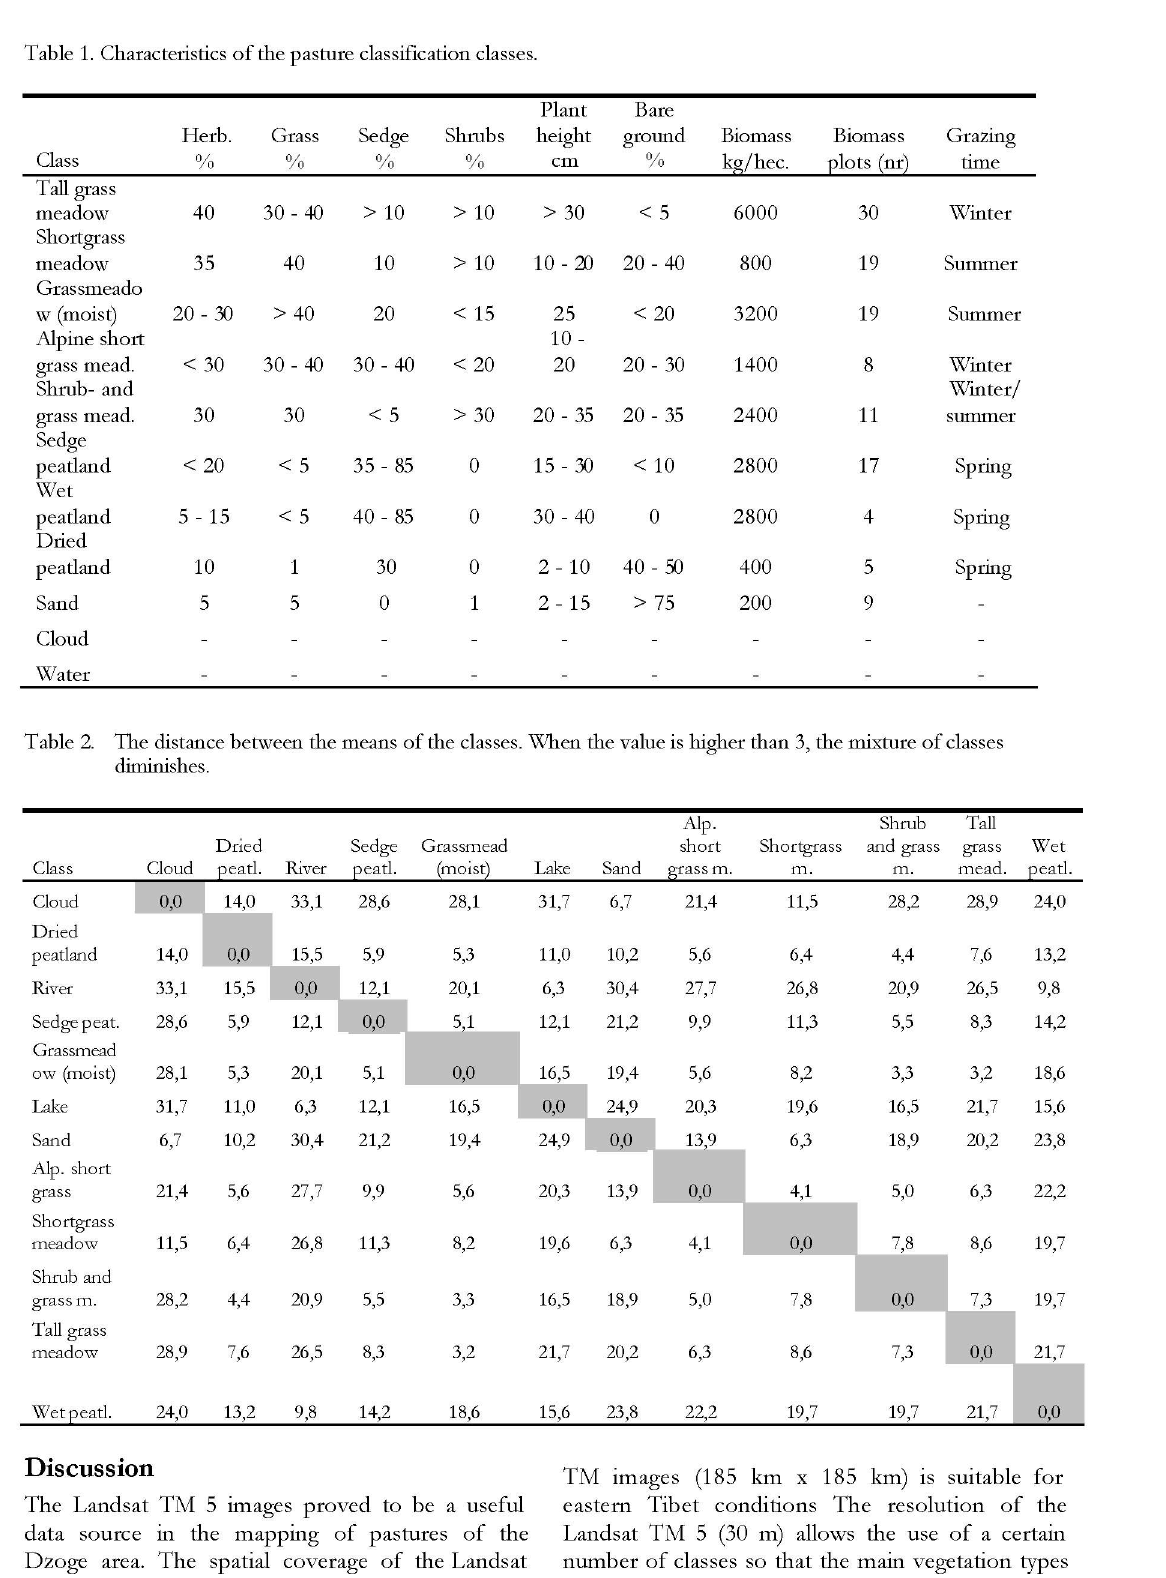
Table 2. The distance between the means of the classes. When the value is higher than 3, the mixture of classes diminishes.